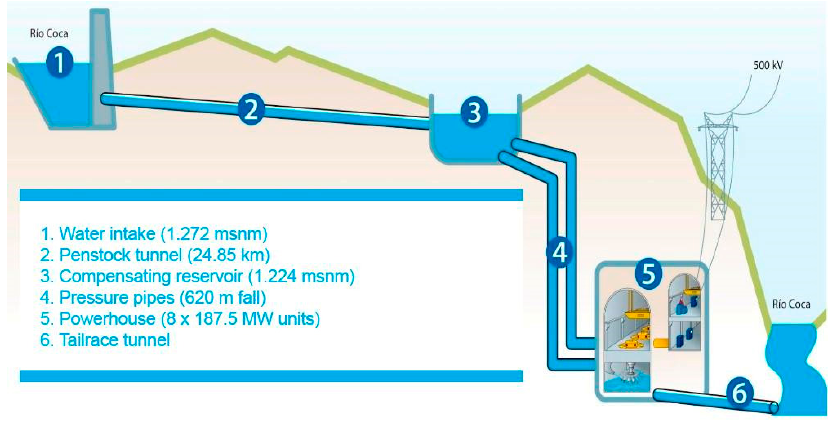
Figure 2. The structure of the Coca Codo Sinclair. Source: modified from [41].